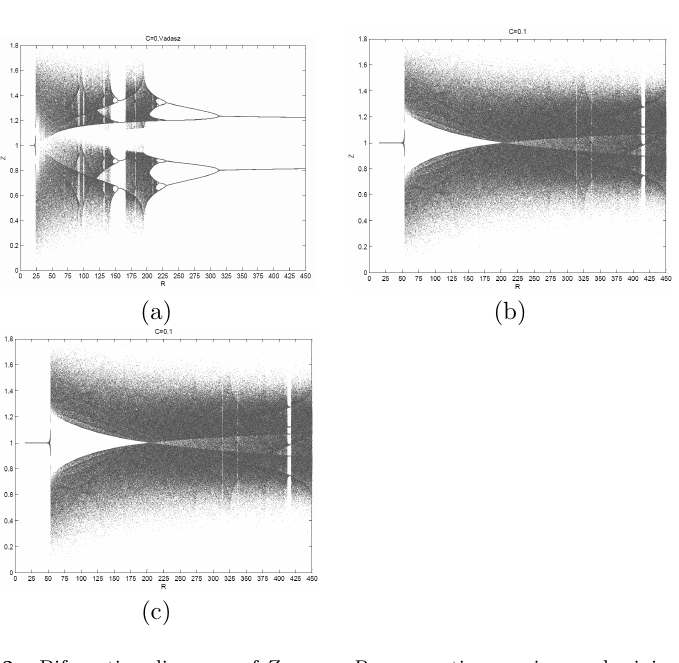
Figure 3. Bifurcation diagrams of Z versus R representing maxima and minima of the post-transient solution of Z ( t ) for Pr = 10, λ = 8 / 3, (a) C = 0 Vadasz case, (b) C = 0 . 1 and (c) C = 0 .